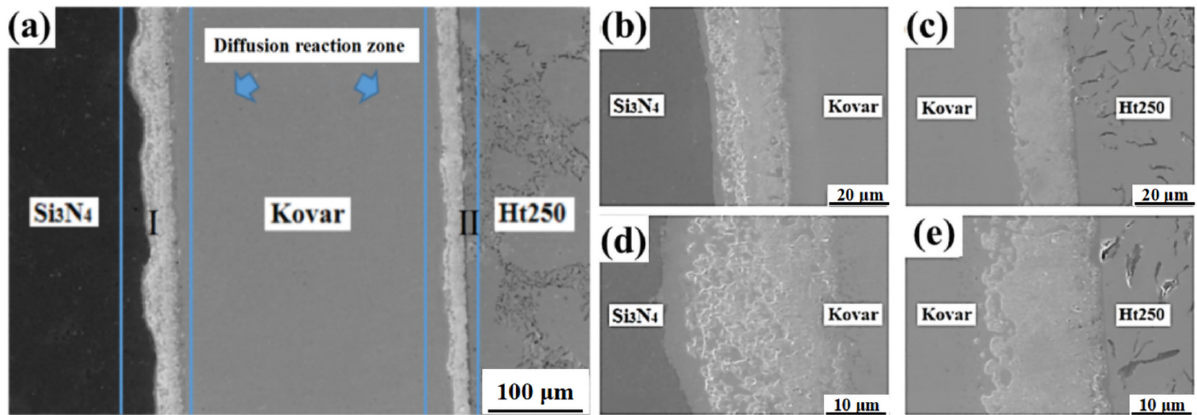
Figure 3. The morphology of the Si 3 N 4 /Ti/Cu/Kovar/Ti/Cu/Ht250 integral joint maintained at 1000 °C for 1 h: ( a , b , d ) microscopic magnification diagrams of diffusion reaction zone I; ( c , e ) microscopic magnification diagram of diffusion reaction zone II.